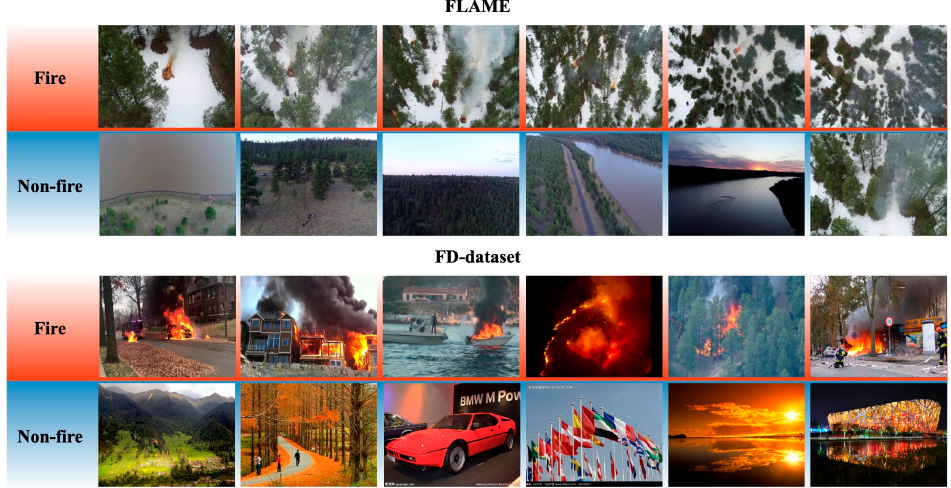
Figure 5. Some sample images from the FLAME and FD-dataset. The first row shows fire samples and the second row illustrates non-fire samples for each dataset.